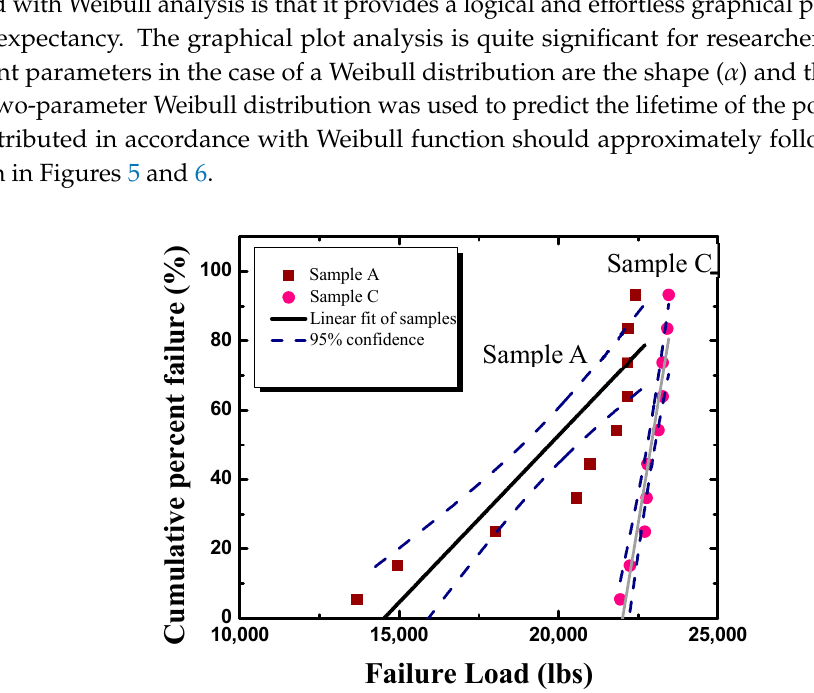
Figure 5. Cumulative probability of failure of the samples based on the mechanical load test with electric voltage (M&E) of the porcelain insulators. Appl. Sci. 2020 , 10 , x FOR PEER REVIEW